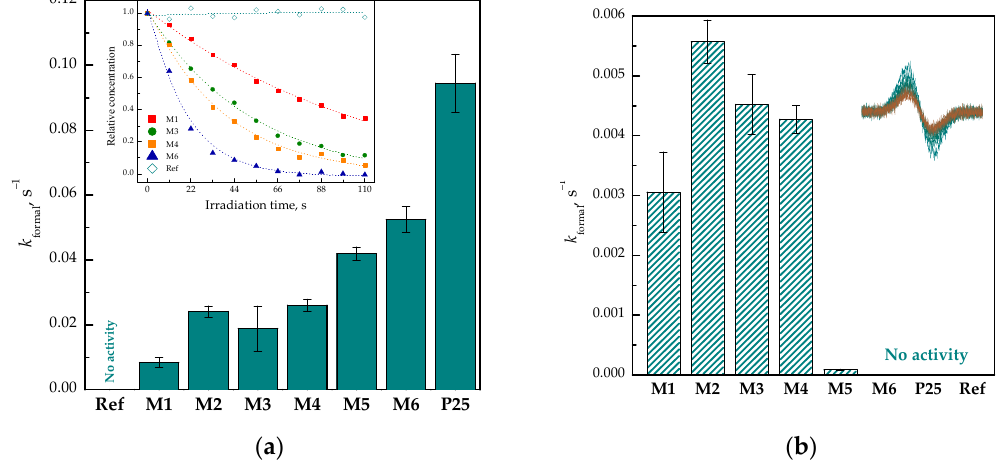
Figure 7. Formal rate constants of 2,2’-azino-bis(3-ethylbenzothiazoline-6-sulfonic acid) diammonium salt (ABTS) •+ radical cation reduction in the presence of photocatalysts M1–M6 and P25, along with reference (photocatalyst ‐ free solution) upon continuous ( a ) UV ( λ max = 365 nm; 15 c (photocatalyst) = 0.33 g L –1 ; c 0 (ABTS •+ ) = 43 μ M. Inset in ( a ): Dependence of the ABTS •+ relative concentration on the irradiation time measured under analogous conditions. Inset in ( b ): Intensity decline in EPR spectra (magnetic field sweep of 6 mT, modulation amplitude of 0.2 mT) of ABTS •+